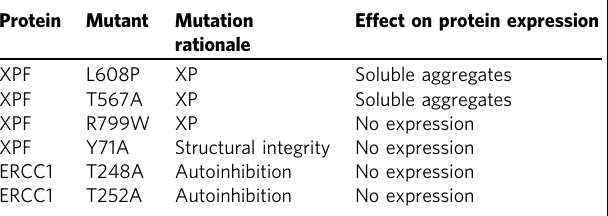
Table 1 XPF – ERCC1 mutants that disrupt protein